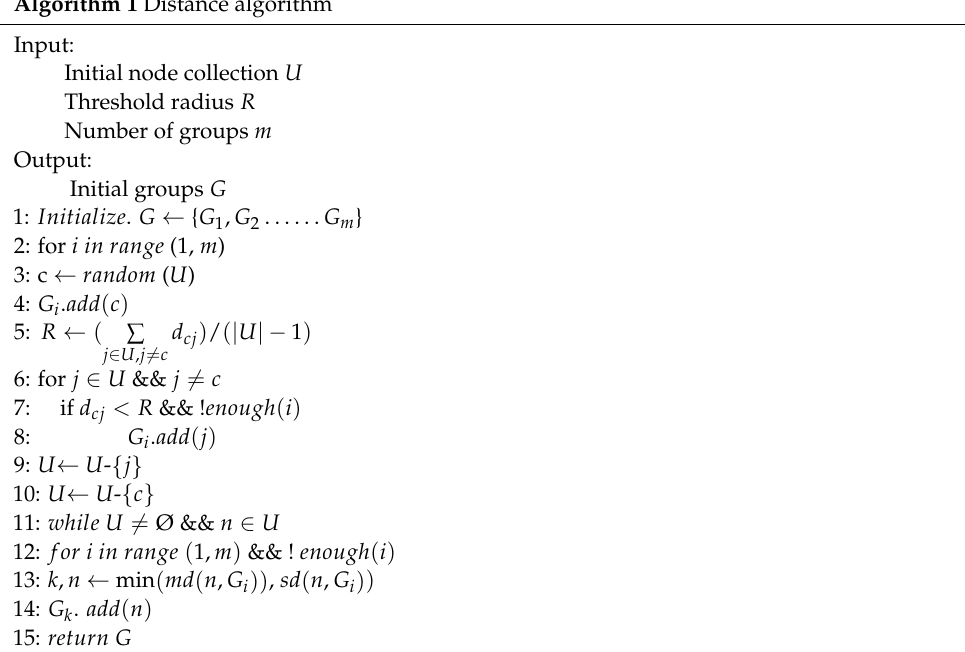
Algorithm 1 Distance